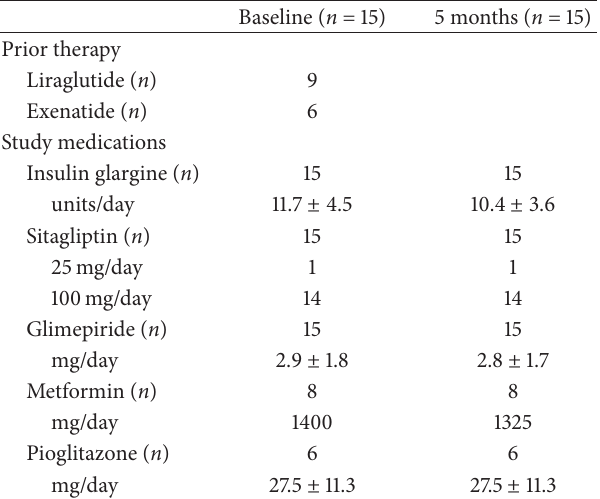
Table 2: Differences of parameters between baseline and after 5 months of treatment.